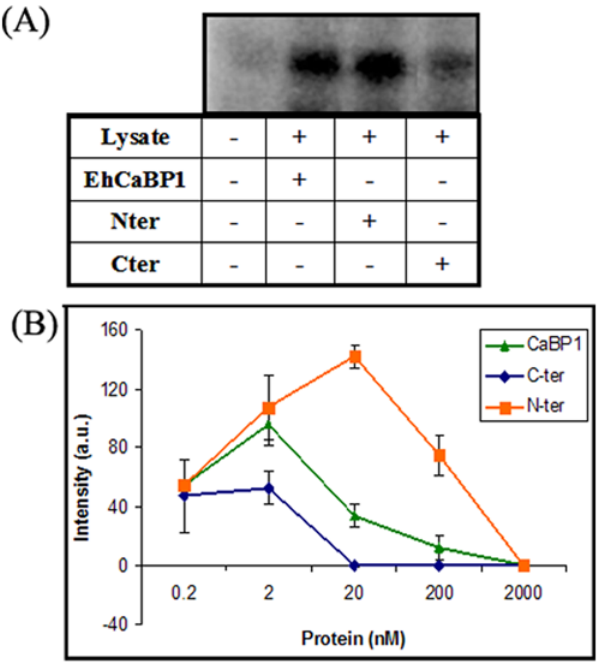
Figure 3. Ability of EhCaBP1 domains to activate endogenous kinase(s). (A) E. histolytica cell-free lysate (25 m g) is used as the source of kinase and histone type III (15 m g) as the substrate. EhCaBP1, Nter or Cter (2 nM) is added to the reaction mixture at varying concentration and the assay is performed using [ c - 32 P] ATP as the phosphate donor. The concentration of Ca 2 + used is 10 m M. The reaction products are separated on a 12% SDS-PAGE, air dried and autoradiography is done. The first lane is histone alone. (B) The amount of radioactivity incorporated into histone as determined by densitometry. The reaction mixtures are precipitated and the incorporated counts are measured using liquid scintillation counter. The graph represents the intensity measurement of three independent experiments 6 s.d.